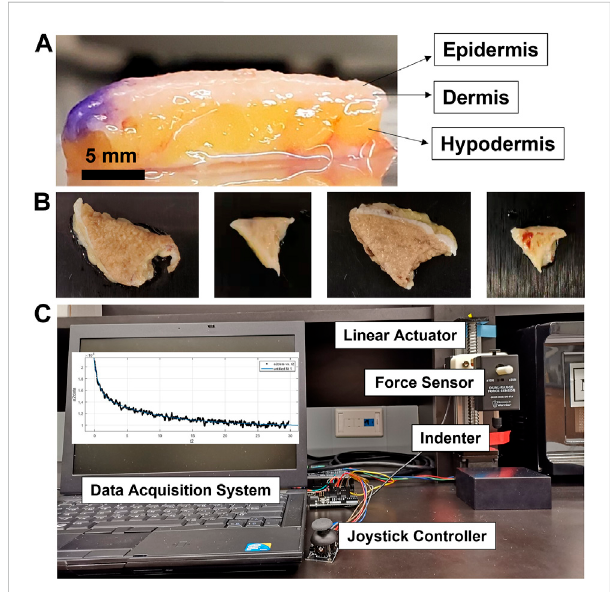
Experimental schematic representation for the characterization of the viscoelastic properties of human skin tissue. (A) Melanoma skin tissues displaying epidermis, dermis, and hypodermis layers. (B) Different-sized and shaped ex vivo melanoma tissues. (C) Experimental set-up for the stress-relaxation test using the indentation-based mechanical analyzer composed of the linear actuator, force sensor, indenter, data acquisition system, and joystick